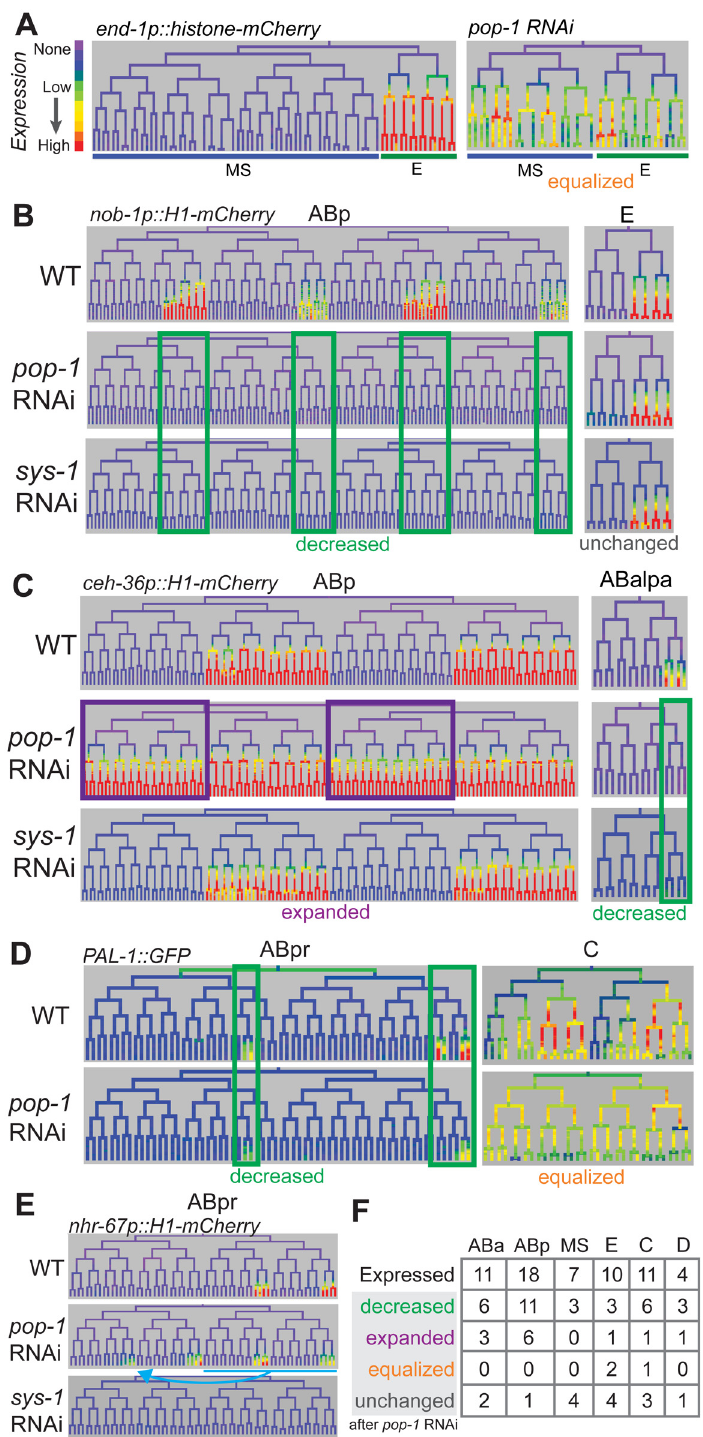
Fig 6. Most genes expressed in multiple posterior lineages are either activated or repressed by pop-1 . A) Expression driven by the end-1 promoter in the EMS lineage is high in the posterior E descendants and absent from the anterior MS descendants. Depleting pop-1 by RNAi increases end-1 promoter activity in the MS lineage and decreases it in the E lineage, equalizing expression as previously demonstrated. B) nob-1 expression in posterior daughter-derived lineages is lost after both pop-1/TCF and sys-1/ β -catenin RNAi (green boxes) in the ABp lineage, but expression is unchanged in the E lineage. C) Expression of ceh-36